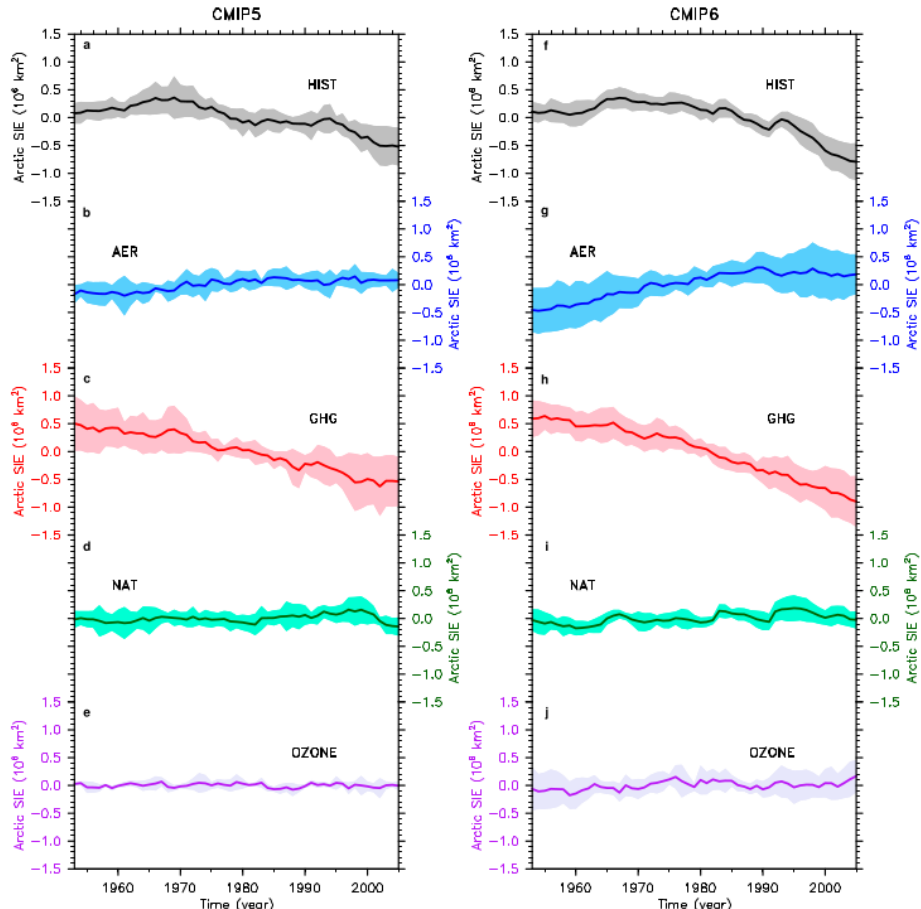
Figure 2. ( a – e ) Annual mean Arctic sea ice extents (relative to the 1953–2005 average) from